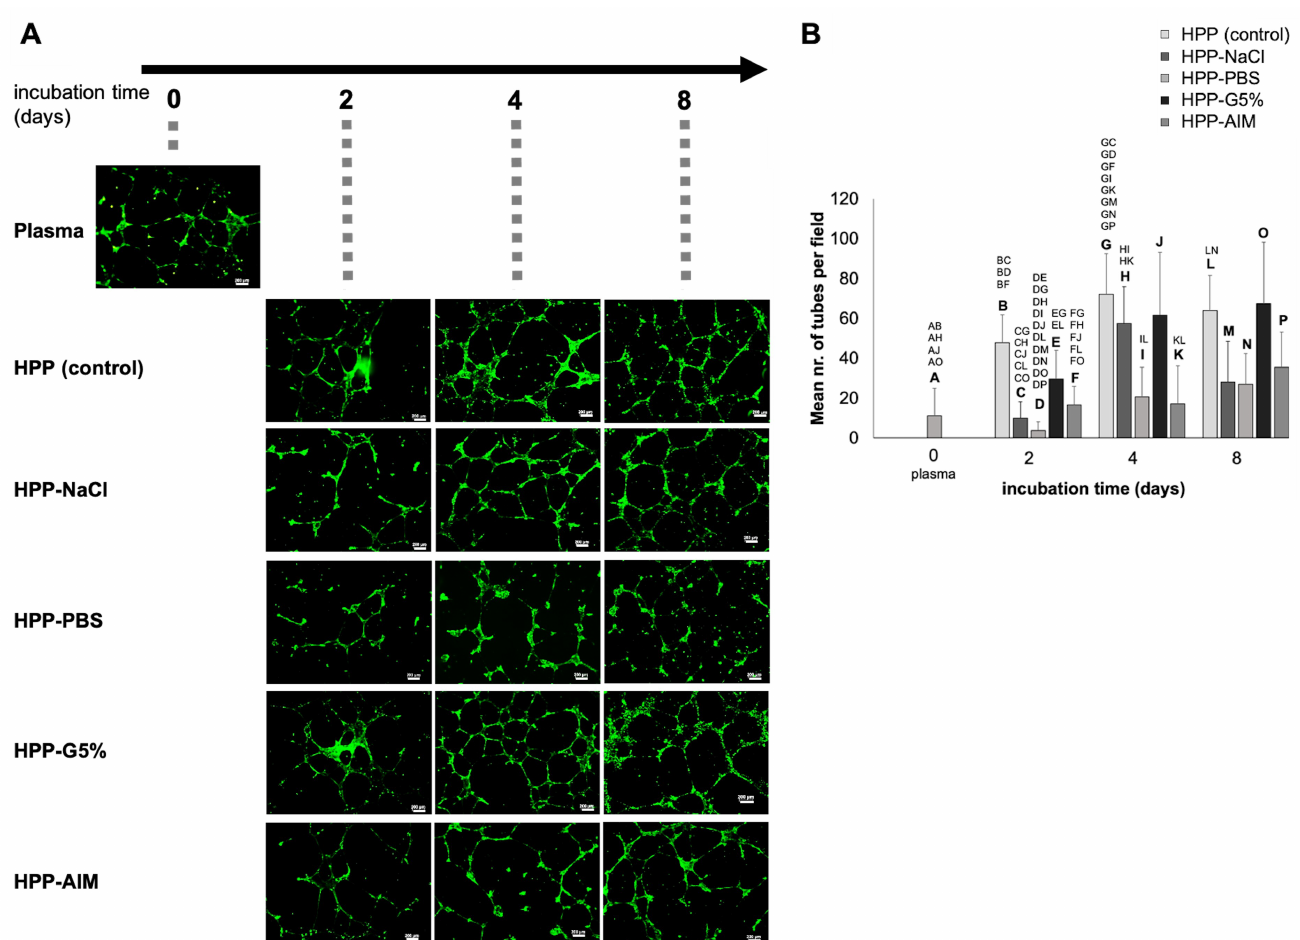
Figure 4. Effect of various anticoagulated blood-derived hypoxia preconditioned media on mi- crovessel formation in endothelial cell cultures in vitro. ( A ) Panel showing representative images of the tube formation assay (12 h culture duration), carried out in the presence of anticoagulated blood-derived secretomes (fresh plasma; hypoxia preconditioned plasma (HPP)) and four different hypoxia preconditioned plasma substitutes: hypoxia preconditioned normal saline (HPP-NaCl), hypoxia preconditioned phosphate buffered saline (HPP-PBS), hypoxia preconditioned Glucose 5% (HPP-G5%), and hypoxia preconditioned AIM medium (HPP-AIM). Blood samples were obtained from 4 young, healthy subjects and conditioning was carried out over 2, 4, and 8 days prior to testing. Scale bars = 200 µ m. ( B ) Plot showing the mean number of tubes formed in HUVEC cultures that were incubated for 12 h with anticoagulated blood-derived secretomes, as described in ( A ). Blood donors: n = 4. Two-way repeated measures ANOVA with Tukey’s multiple comparison test. Data points are means ± SD. Capital letter pairs over plots indicate statistical comparison of corresponding data points unless otherwise indicated. For all pair comparisons, p <